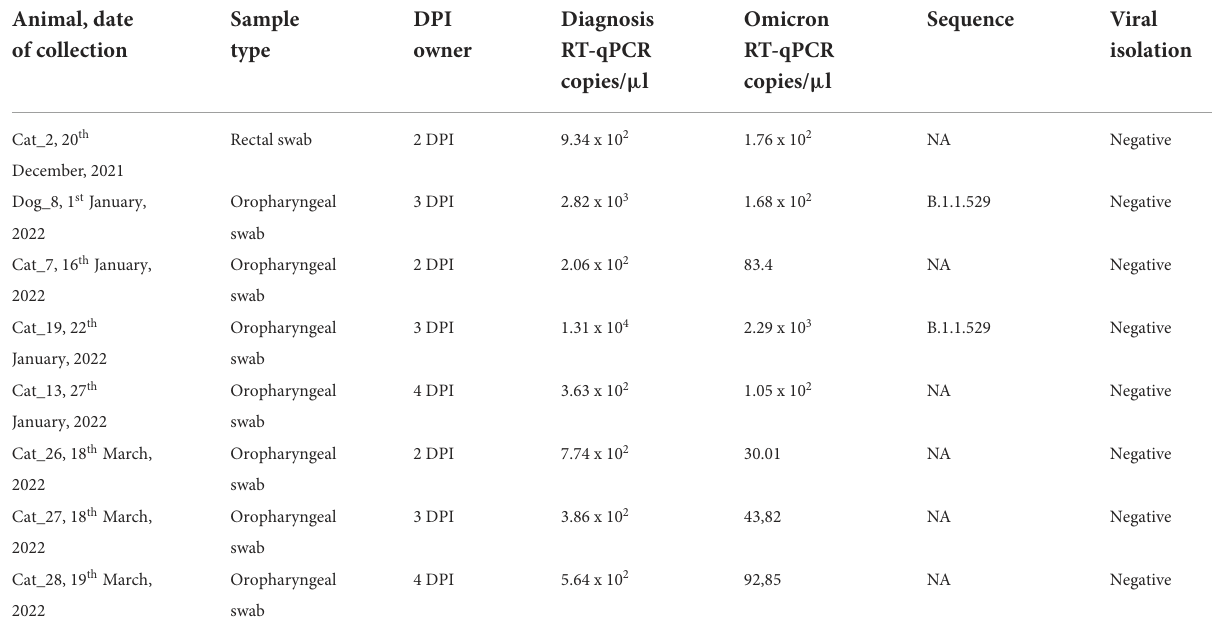
TABLE 1 Virus detection in canine and feline